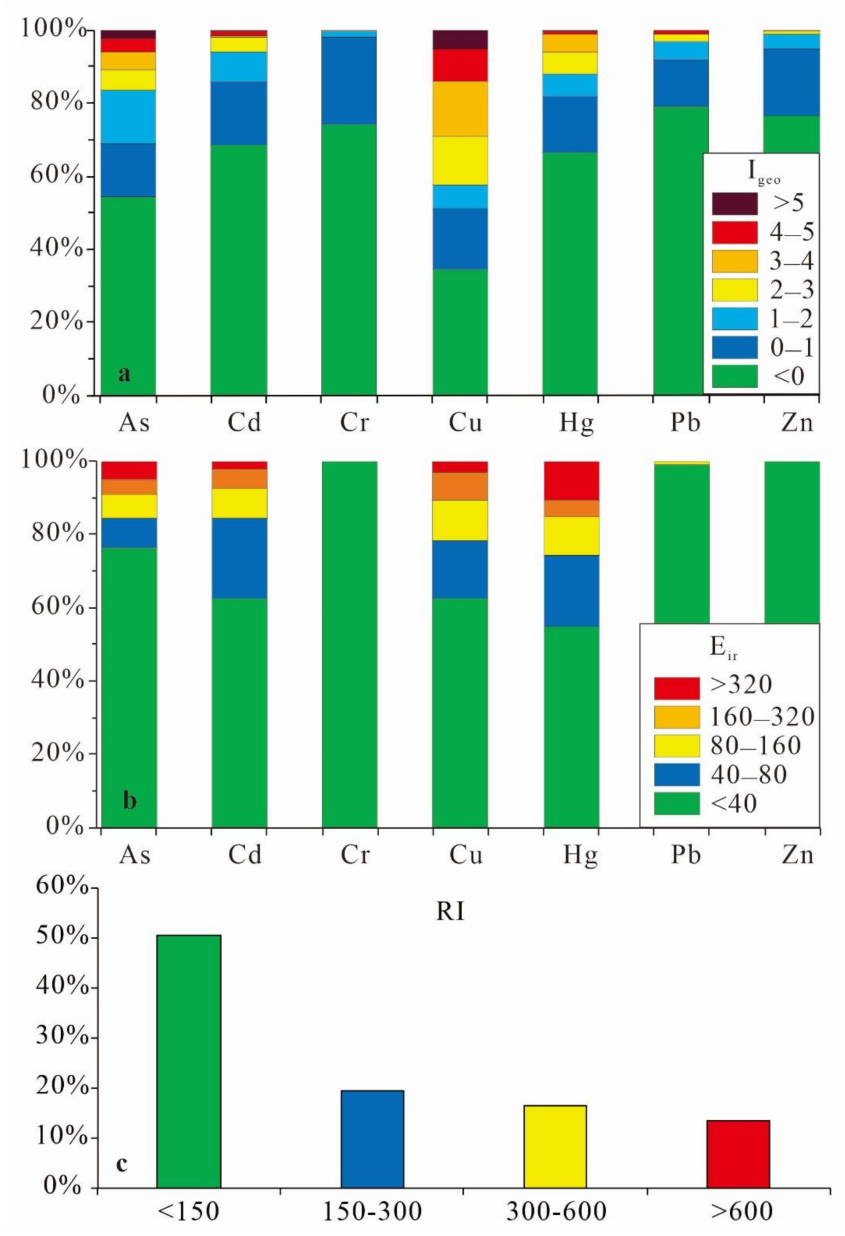
Figure 8. Proportions of different ( a ) I geo , ( b ) E ir , and ( c ) RI levels of HMs in all sediment samples (n =